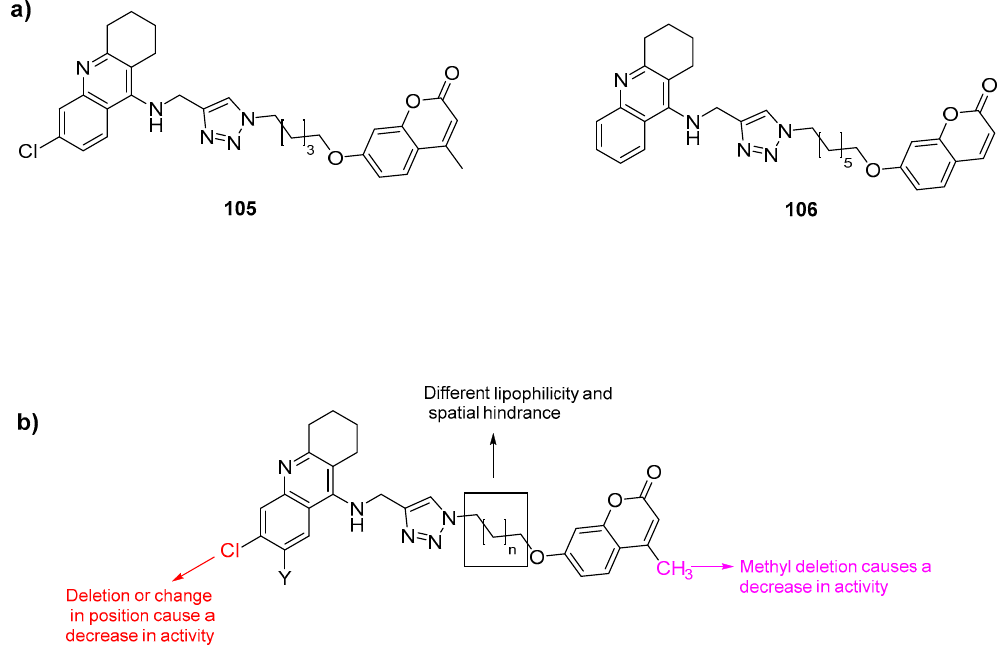
Figure 40. ( a ) Chemical structure of compounds 105 and 106 ; panel ( b ) SAR studies.